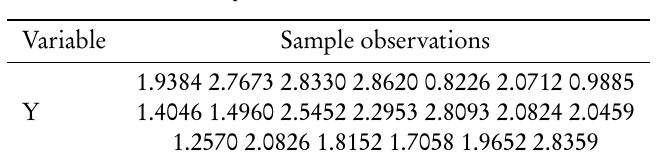
Sample observations - Case